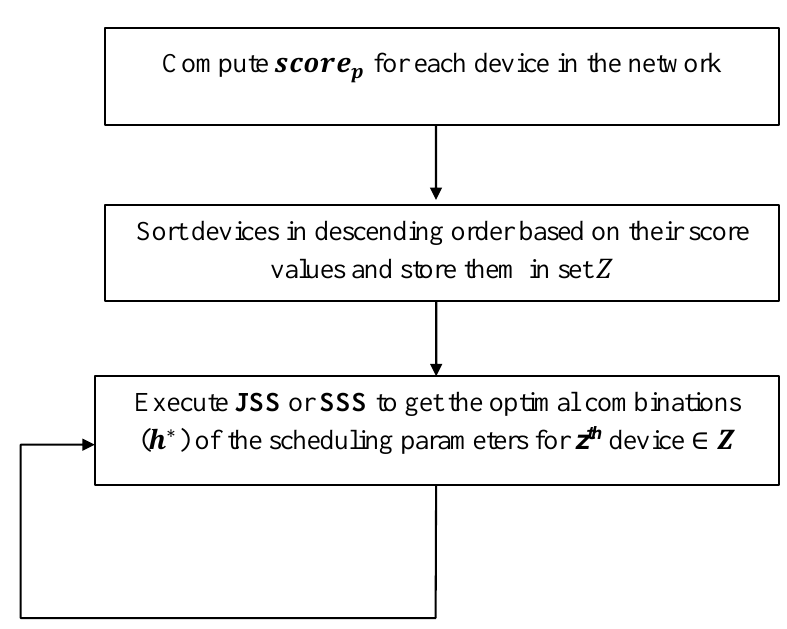
Figure 4. Block diagram describing steps of the sorting score technique